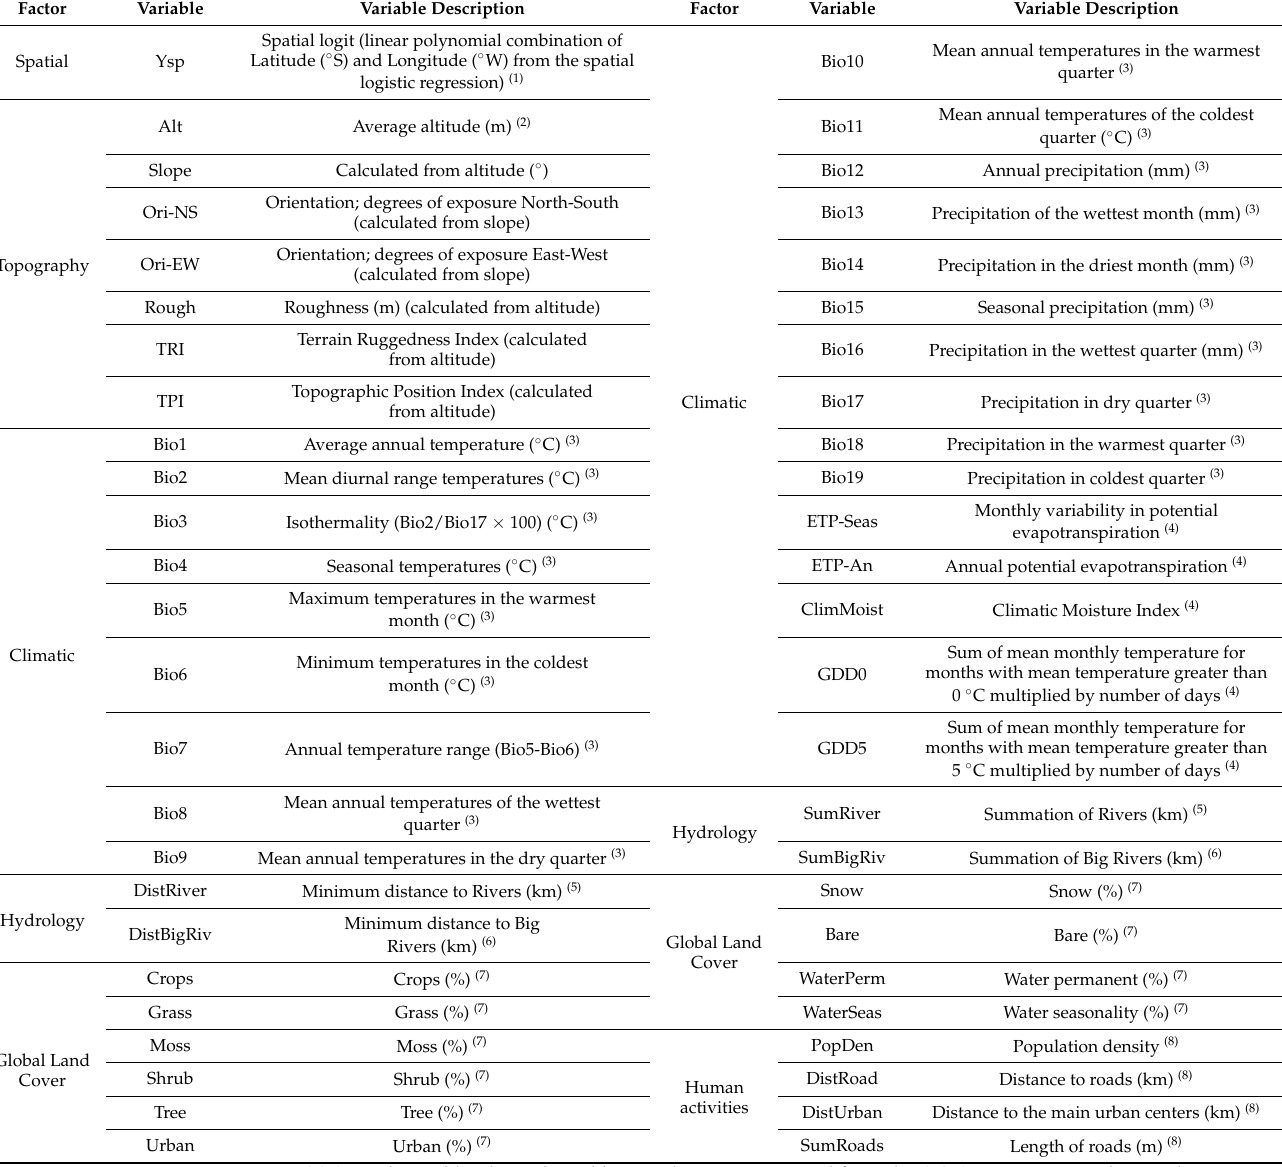
Table A1. List of environmental and geographical variables, and factors belong to, used for SDM